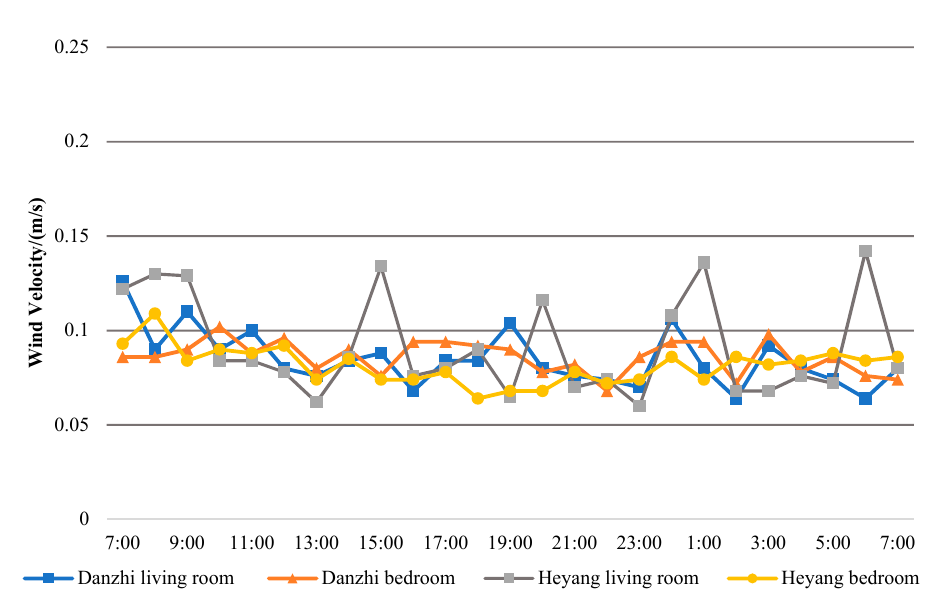
Figure 13. Average air velocity in Heyang and Danzhi villages over 24 h during the plum rain season.